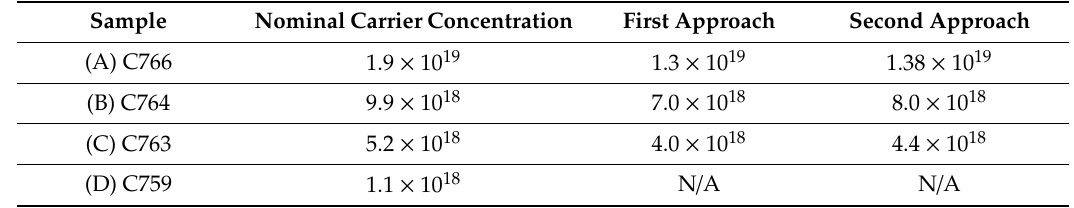
Table 2. The samples’ description and growth protocol.